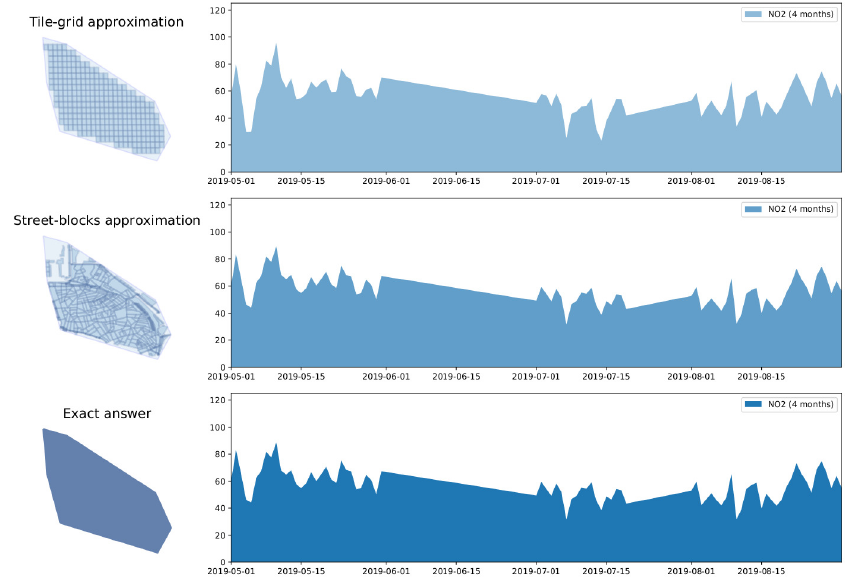
Figure 9. Progressive approximate query answering: The approximate time series at the top gets gradually refined until the exact answer is presented to the